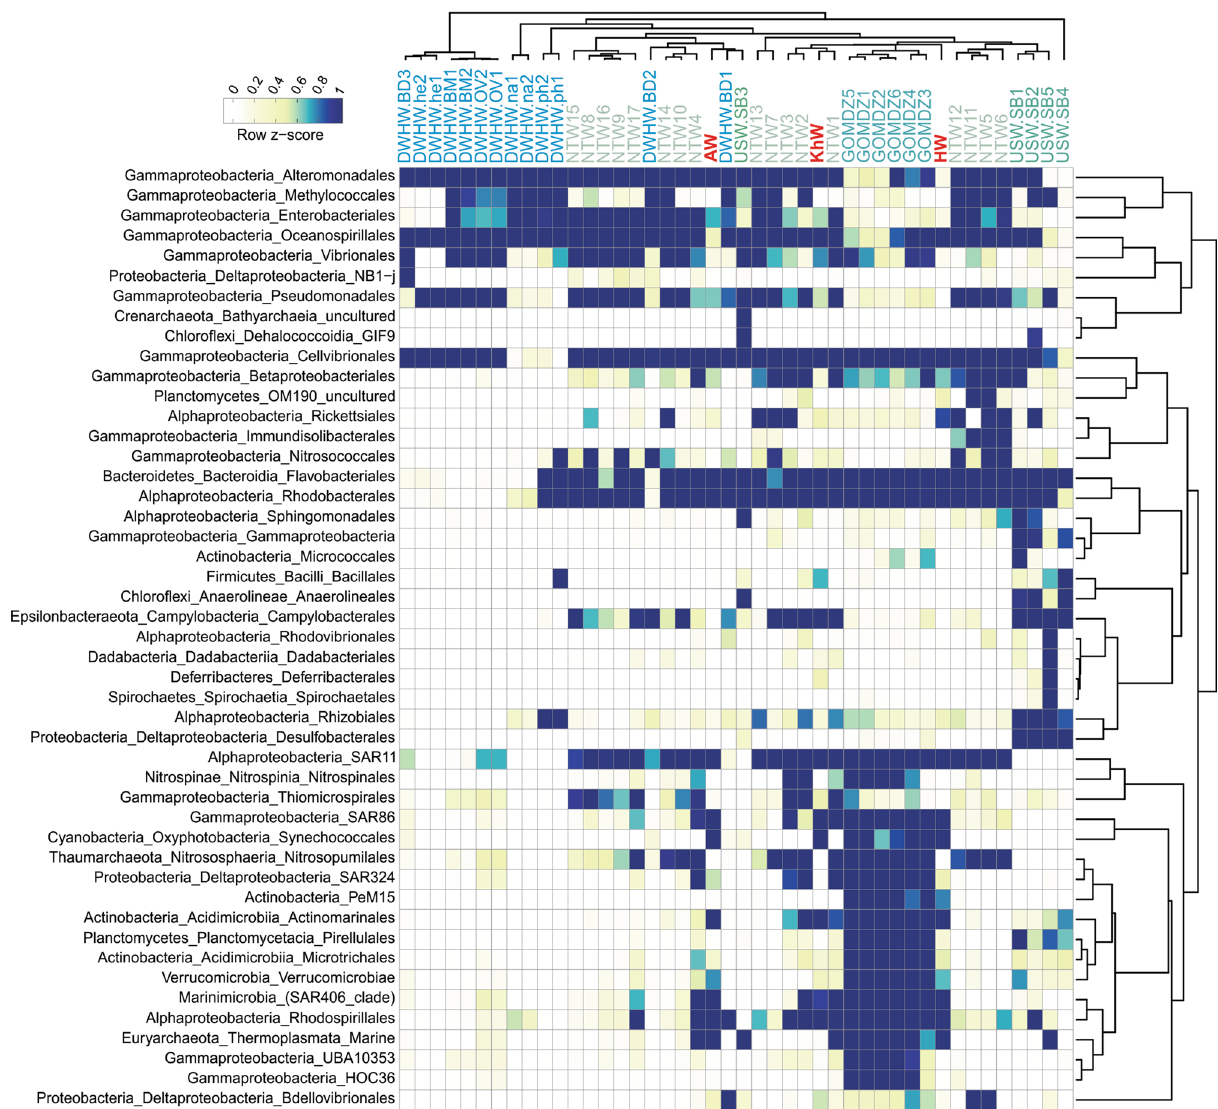
Figure 3. The abundance of unassembled 16S rDNA reads from unassembled metagenomes of different oil- polluted water samples (41). Row names are microbial taxa at the order level. For taxa with lower frequency, the higher taxonomic level is shown (47 taxa in total). The right-hand dendrogram represents the clustering of rows based on the Pearson correlation. Columns are the name of water samples. Samples are clustered based on Pearson correlation and the color scale on the top left represents the row Z-score. Figure was plotted using “circlize” and “ComplexHeatmap” packages in